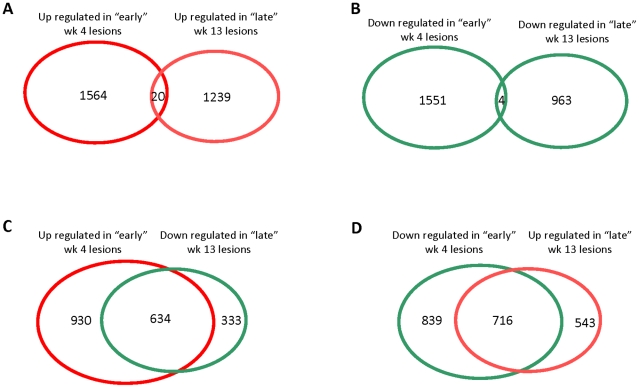
Reprogramming of lesion transcriptome occurs in late, relative to early granulomas.Venn diagrams show the degree of overlap between commonly up regulated (A) and commonly down regulated (B) genes between week 4 and week 13 granuloma lesions. Similarly, overlap is also shown between genes up regulated in week 4 granulomas and down regulated in week 13 granulomas. Genes up regulated in various analyses are represented in red while those down regulated in various analyses are represented in green. The analyses included genes induced or repressed more than 2-fold in a statistically significant manner in all three “early” relative to “late” animals.